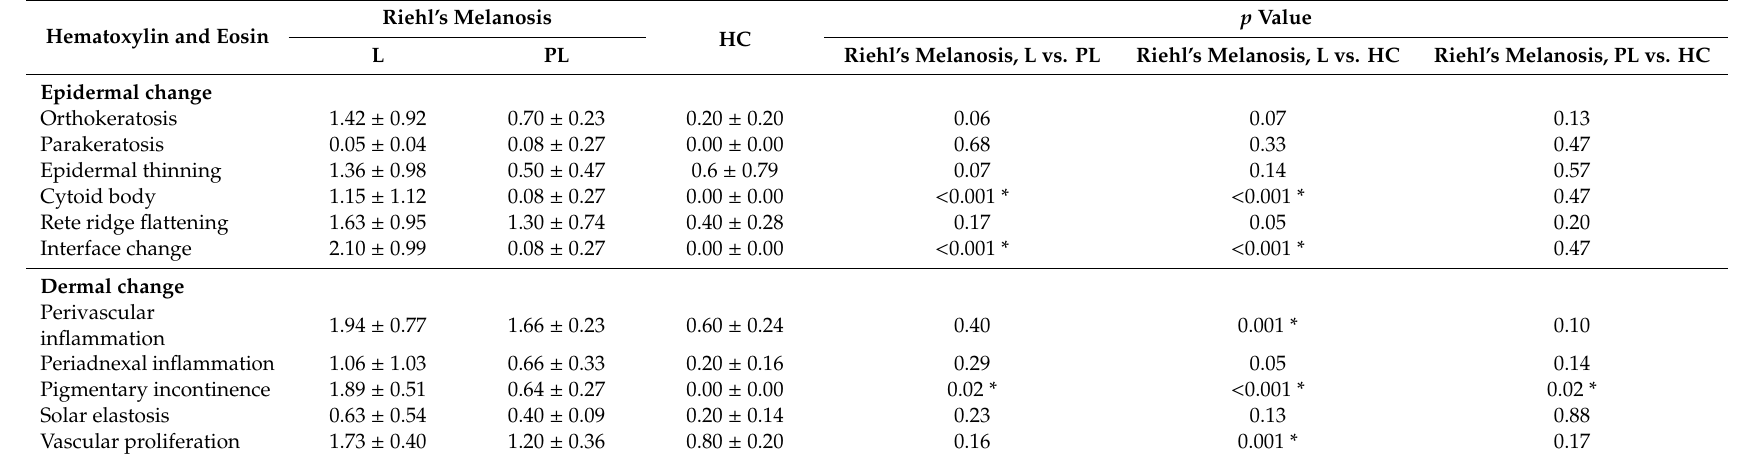
Table 1. Comparison of general histopathological patterns in the lesional skin and perilesional normal-appearing skin of Riehl’s melanosis and healthy controls. p Value Riehl’s Melanosis Hematoxylin and Eosin HC L PL Riehl’s Melanosis, L vs. PL Riehl’s Melanosis, L vs. HC Riehl’s Melanosis, PL vs. HC